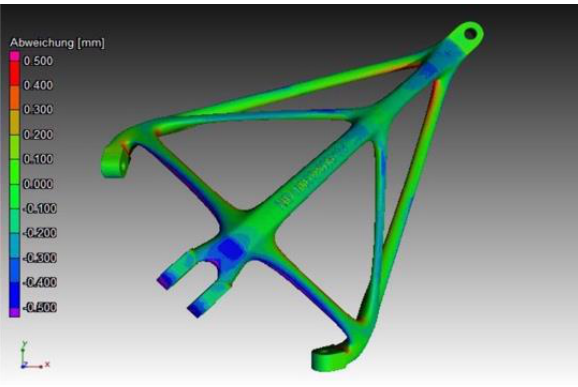
Figure 23. Actual versus nominal comparison of a leg from the CT data.